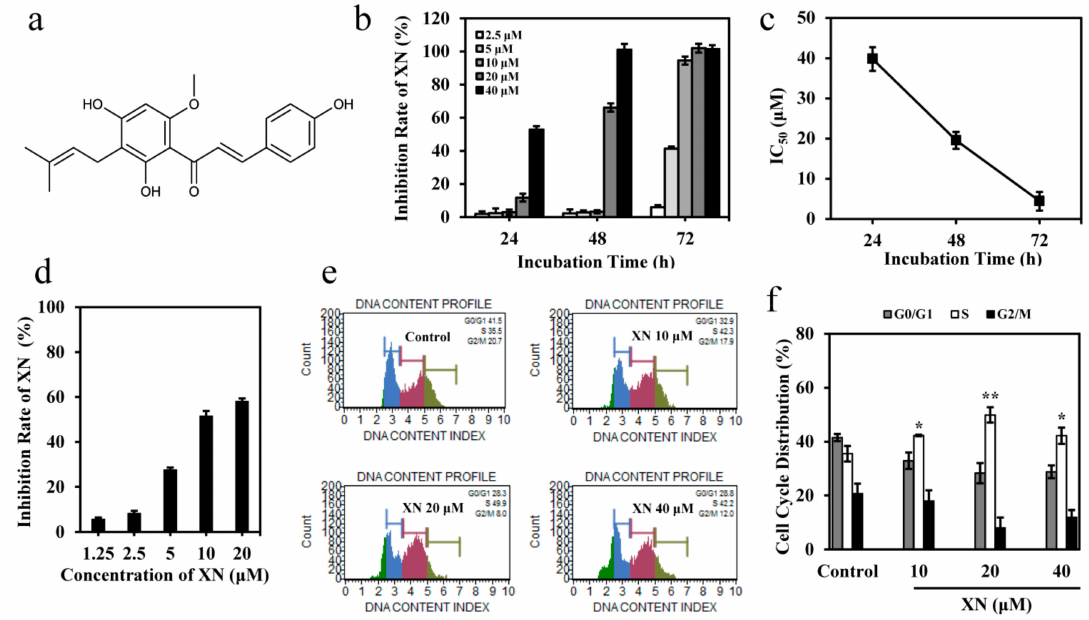
Figure 1. Xanthohumol (XN) decreases cell viability of K562 cells. ( a ) Chemical structure of XN. ( b ) Proliferation inhibition rates (%) of XN against K562 cells. K562 cells were treated with XN (0–40 µ M) for 24–72 h. Cell viability was subjected to MTT assay. ( c ) The IC 50 values of XN against K562 cells at 24–72 h, respectively. ( d ) Proliferation inhibition rates (%) of XN against K562 / ADR cells. K562 / ADR cells were treated with XN at concentrations of 0–20 µ M for 72 h, and then subjected to MTT assay. ( e ) XN induces cell cycle arrest at S phase. K562 cells were treated with XN (0–40 µ M) for indicated time and the cell cycle distribution was measured using Muse Cells Analyzer. ( f ) The bar graph depicts the percentage of each cell cycle phase of K562 cells in the absence or presence of XN. Values are expressed as mean ± SD of three independent experiments. * p < 0.05, ** p < 0.01, versus